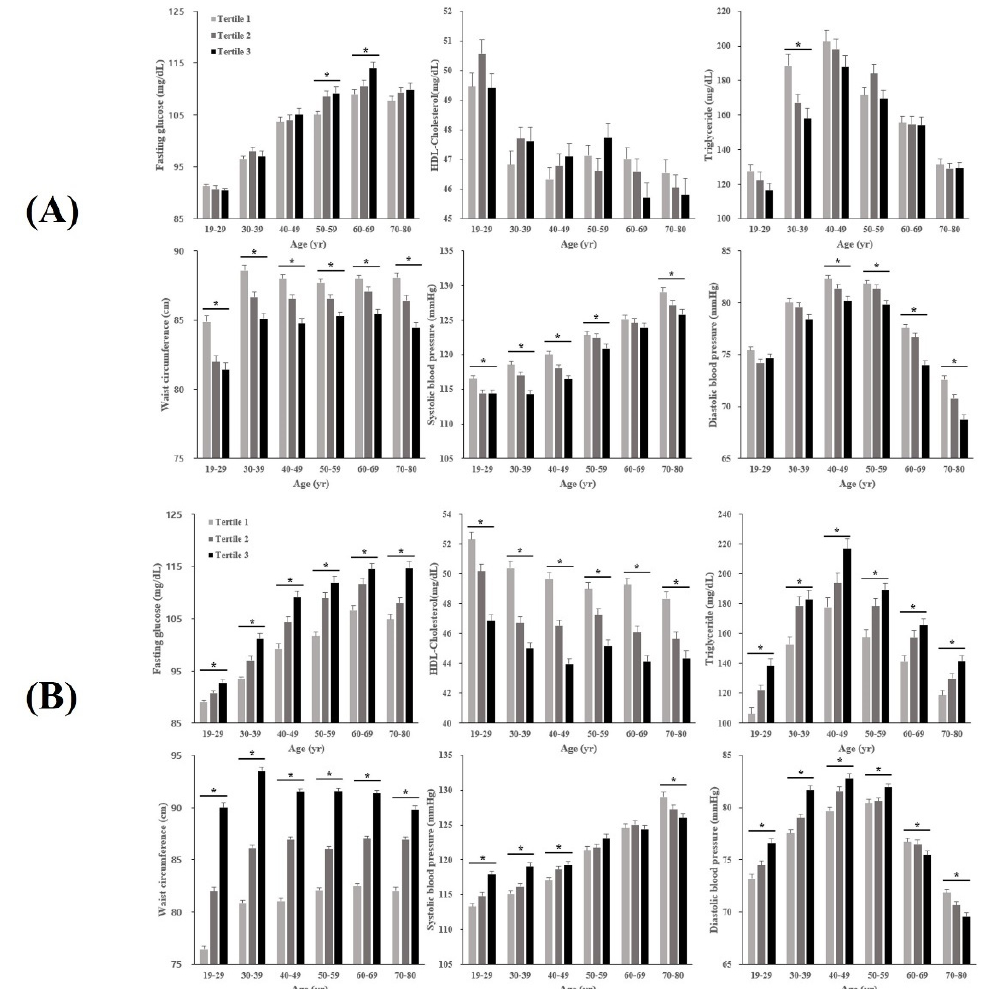
Figure 2. Metabolic syndrome components across absolute ( A ) and relative ( B ) handgrip strength tertiles in men, stratified by age. Note: T1 (first tertile), highest; T2 (second tertile), intermediate; T3 (third tertile), lowest. * p -value tests for a difference between groups by handgrip strength tertile using ANOVA ( p < 0.05). Abbreviations: HDL-C, high-density lipoprotein-cholesterol.